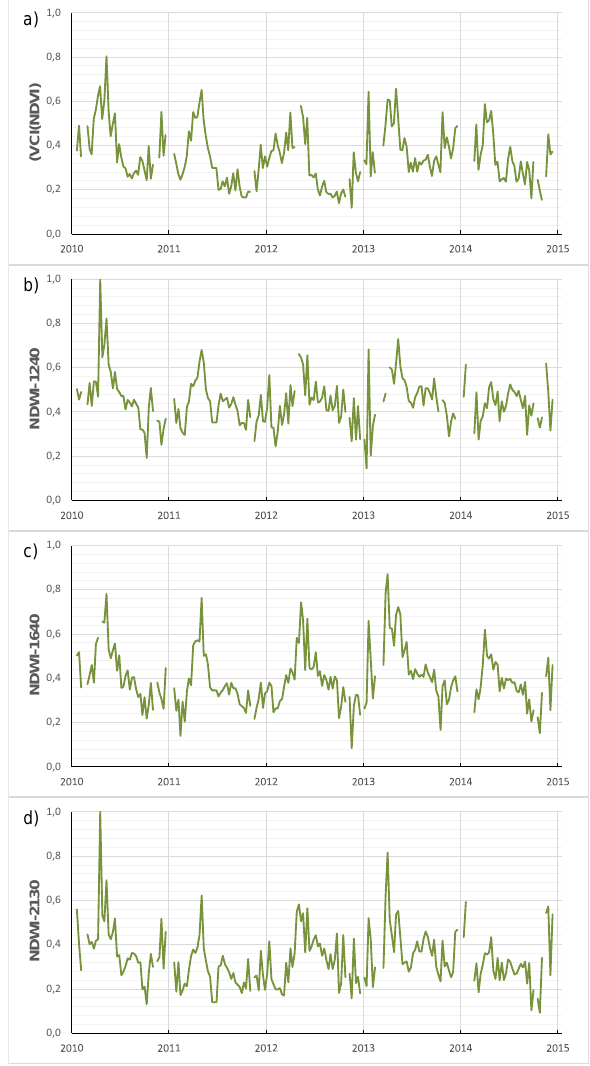
Figure 3. Temporal cycle of VCI after the different alternatives (d).